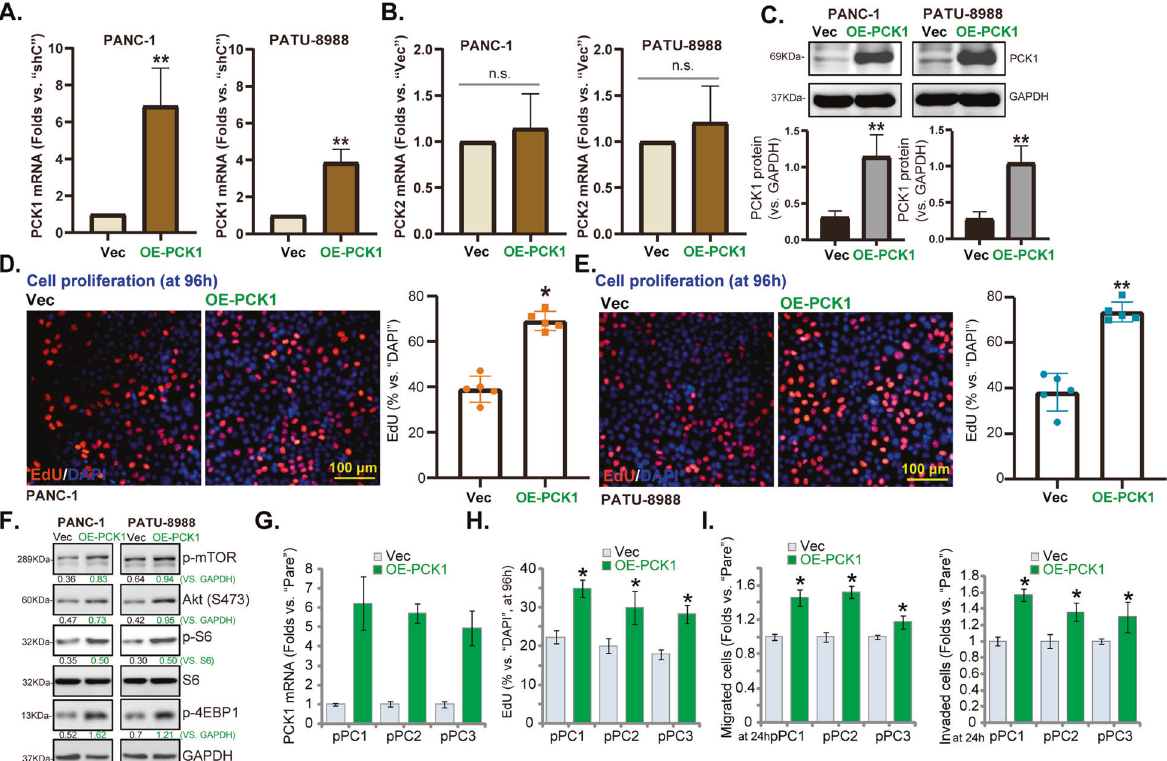
Fig. 6 Exogenous overexpression of PCK1 augments pancreatic cancer cell growth and motility. Established pancreatic cancer cell lines (PANC-1 and PATU-8988) ( A – F ) or the primary pancreatic cancer cells ( “ pPC1/2/3 ” ) ( G – I ) with a lentiviral construct encoding the PCK1 cDNA ( “ OE-PCK1 ” ) or the empty vector ( “ Vec ” ), were established and cultured for applied time periods; Expression of listed mRNA and proteins were tested by qRT-PCR and Western blotting assays ( A – C , F , G ); Cell proliferation (EdU-positive nuclei ratio, D , H ), migration and invasion ( “ Transwell ” assays, I ) were tested by the listed assays, with data quanti fi ed. Data were presented as mean ± standard deviation (SD, n = 5). * P < 0.05 vs. “ Vec ” cells. “ n.s. ” stands for non-statistical difference ( B ). The experiments were repeated fi ve times with similar results obtained. Scale bar = 100 μ m ( D , E